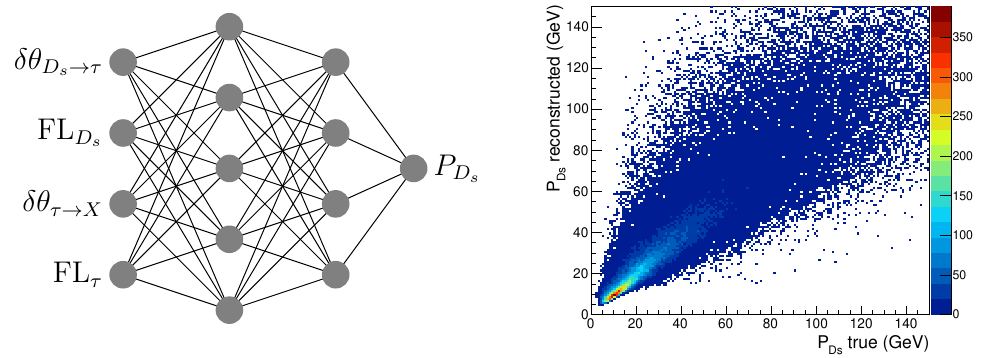
Figure 6 . Left: design of a neutral network for reconstruction of the D s momentum using the topological variables (cid:18) D , (cid:18) (cid:28) ! X , FL D , FL (cid:28) ! X . Right: reconstructed D s momentum versus s ! (cid:28) s ! (cid:28) its true value. A Gaussian (cid:12)t of (cid:1) P=P provides (cid:27) of